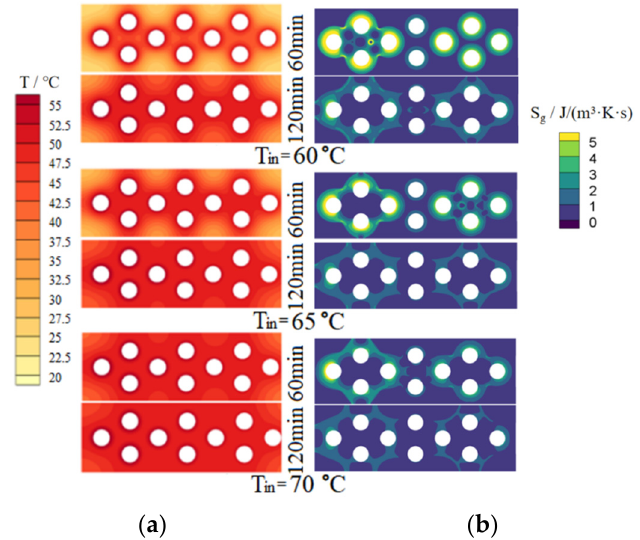
Figure 9. Simulated temperature and entropy generation rate fields of PCM-2 upper surface. ( a ) Temperature fields; ( b ) Entropy generation rate fields.